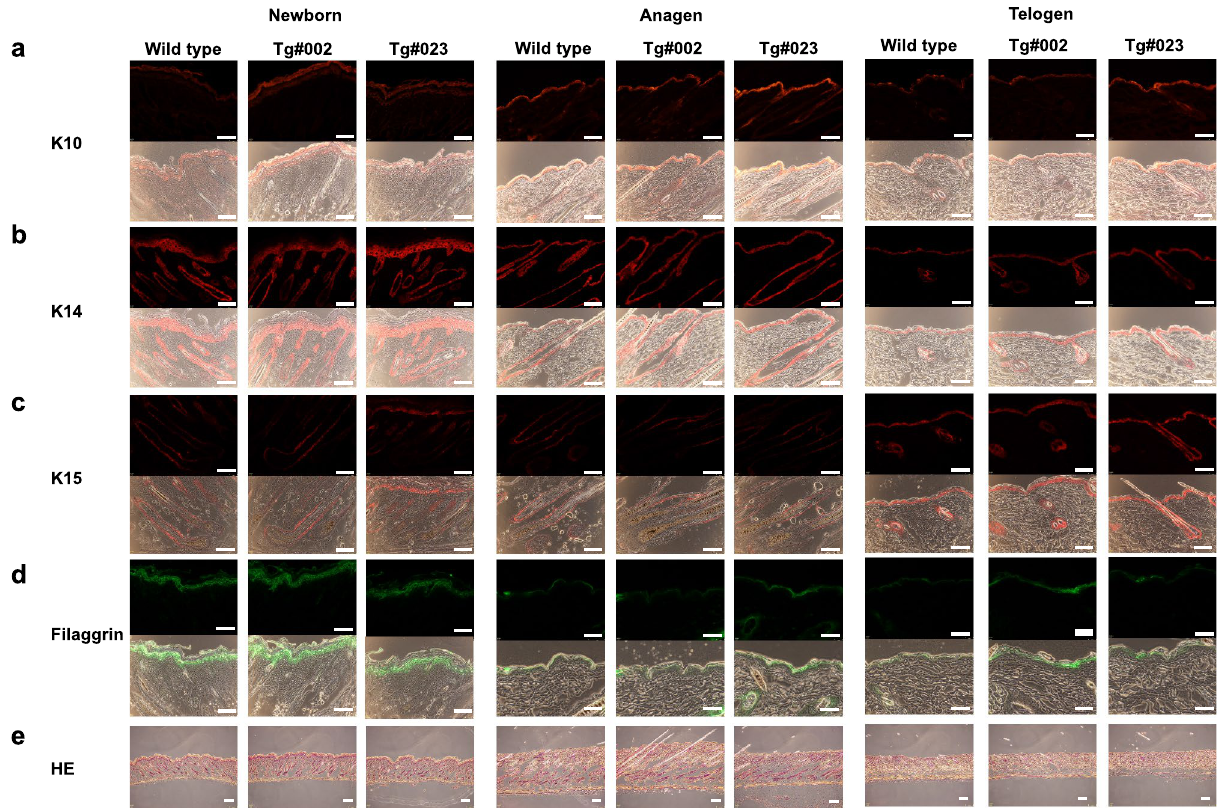
Figure 3. Effect of ectopic expression of NKIRAS2 on the development of epidermal tissue. ( a – d ) To test the effect of ectopic expression of NKIRAS2 on the development of epidermal tissue, epidermal sections from wild type, NKIRAS2 #002 and #023 transgenic mice were stained with an anti-K10, K14, K15 and filaggrin antibody (K10, K14 and K15 were stained with red, and filaggrin was stained with green). Photographs of phase contrast were also taken, and were merged with the photograph of immunofluorescence analysis. Scale bar = 32 µm. ( e ) To show the development of skin, frozen sections of skin prepared from wild type and transgenic mice #002 and #023 were stained with H&E. Scale bar = 311